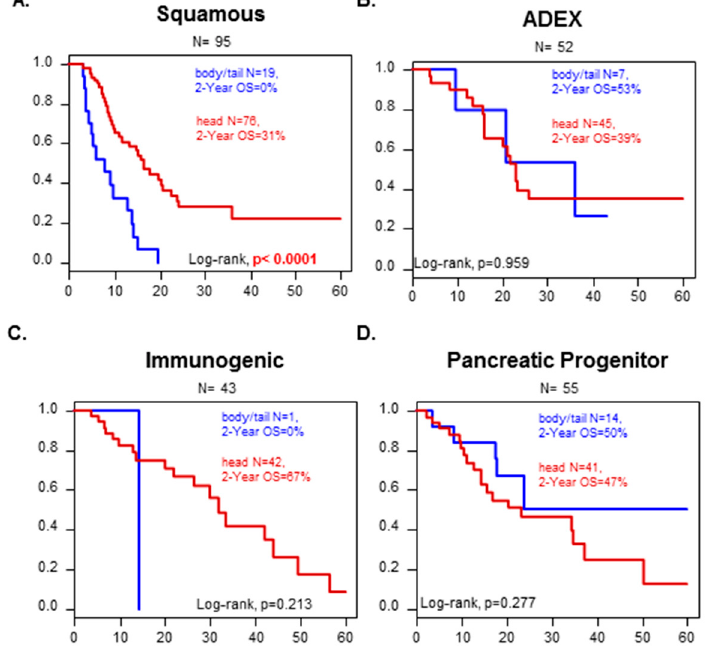
Figure 2. OS in the validation set according to Head or Body/Tail in the different Bailey’s molecular subtypes. Kaplan–Meier OS curves according to PDAC location (Head vs. B/T) and the molecular subtypes defined by Bailey ( A ) Squamous, ( B ) ADEX, and ( C ) Immunogenic, and ( D ) Pancreatic progenitor. The p -values (log-rank test) for the comparison between the two classes within each molecular subtype are indicated.